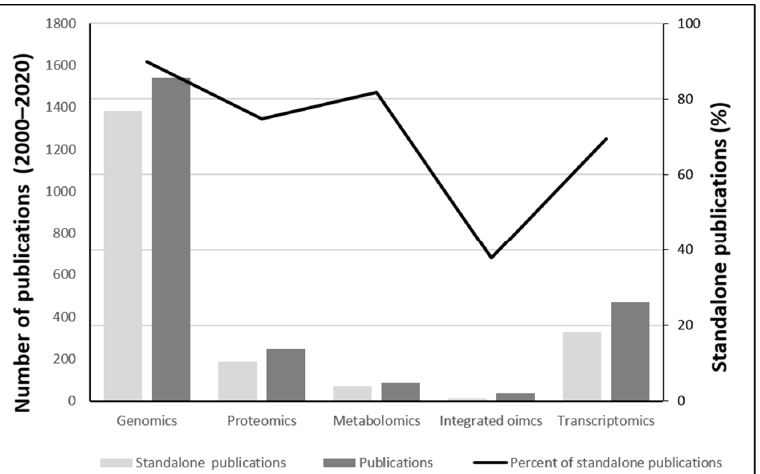
Figure 1. Total and standalone publications in radiation biology retrieved for different omics searches from the year 2000–2020. Searches were performed in the NCBI Pubmed database, and reviews were excluded. Standalone publications are those publications, where no additional methods were used.